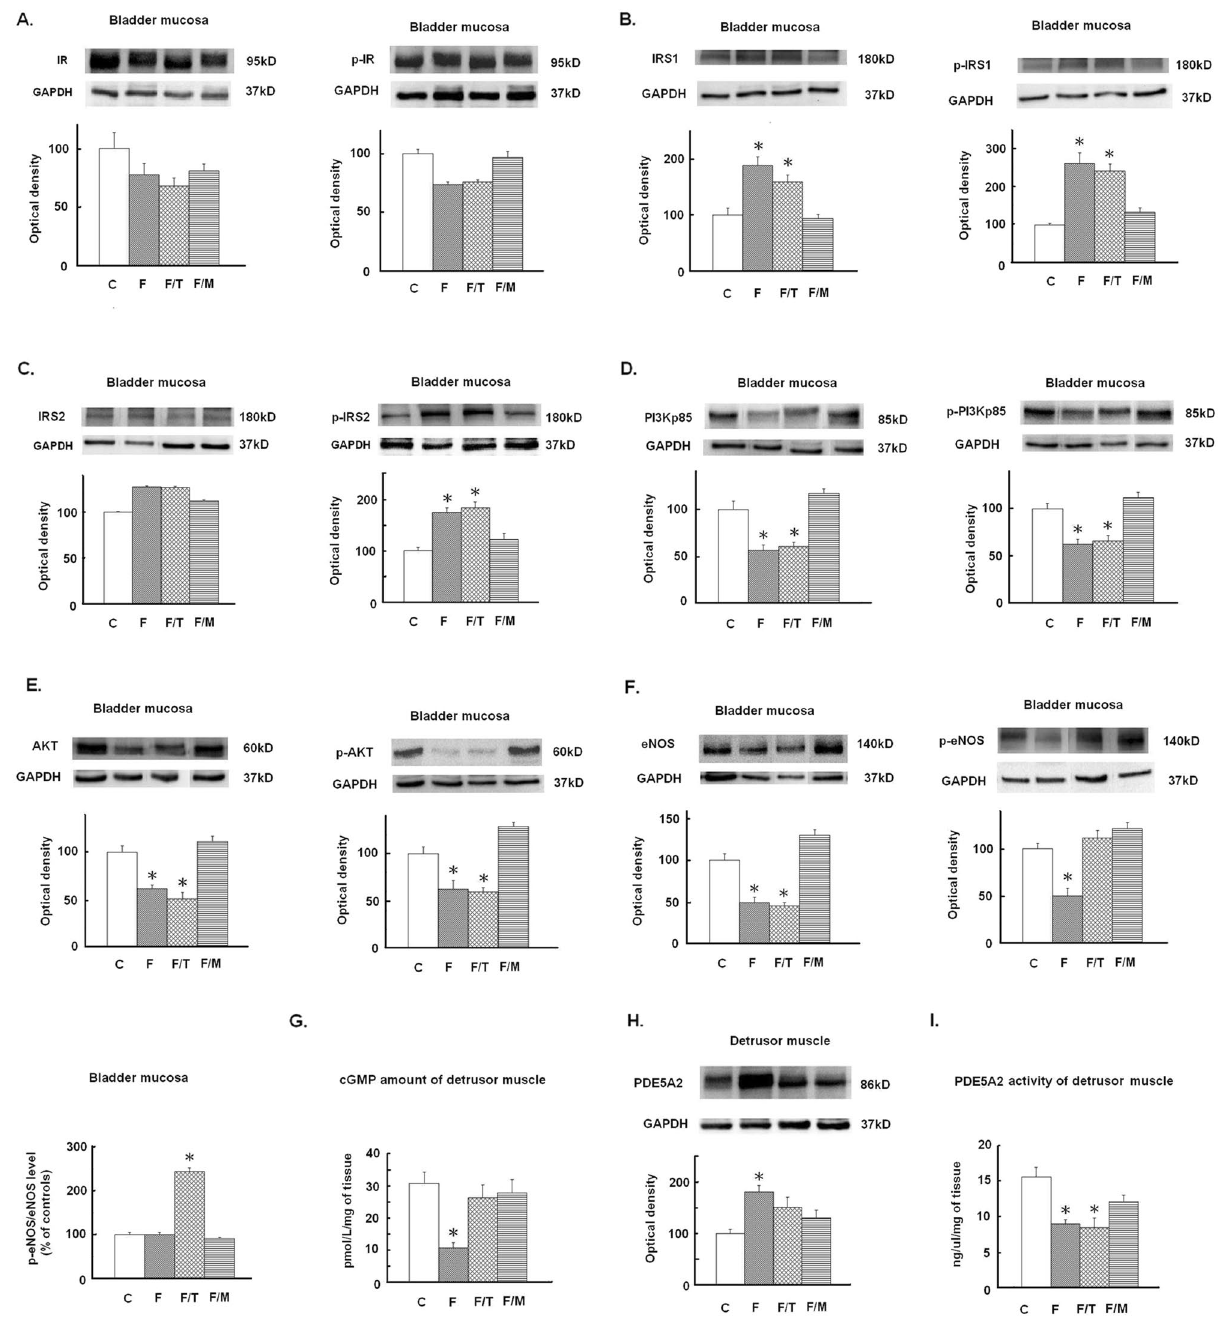
Figure 3. Insulin signalling of IR/IRS/PI3K/AKT/eNOS pathway in mucosa, and cGMP level and PDE5 expression and activity in detrusor in control (C) and fructose fed rats (F), alone or with addition of tadalafil (T) or metformin (M) treatment. Representative Western blot gels and densitometric analysis of total and phosphorylated (p) IR ( A ), IRS1 ( B ), IRS2 ( C ), PI3Kp85 ( D ), Akt ( E ), eNOS ( F ) in the bladder mucosa, as well as cGMP level ( G ) and protein expression ( H ) and activity of PDE5A2 ( I ) in bladder detrusor. The cGMP level and PDE5 activity in detrusor were evaluated by ELISA. Group data are expressed in percentage to the control group denoted as 100%. Data are presented in mean ± SEM, n = 8 in each group. *p < 0.05 in comparison with the control group by one-way ANOVA with Dunnett’s